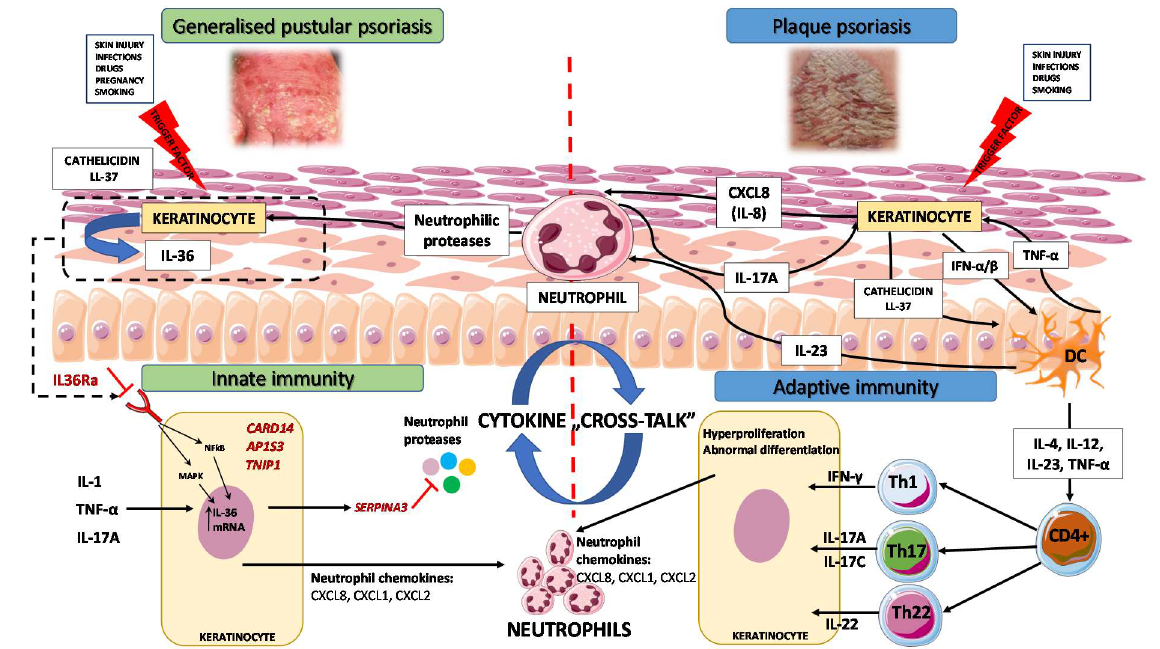
Figure 1. Pathogenesis of generalized pustular psoriasis and plaque psoriasis—a cross-talk between innate and adaptive immunity (modified from [63]). In GPP, skin injury causes dead keratinocytes to release cathelicidin LL-37, a protein that stimulates surrounding keratinocytes to release IL-36, which further enhances the production of different chemokines and recruitment of neutrophils, T cells, dendritic cells, and monocytes. IL-36 expression is induced by other pro-inflammatory cytokines, such as IL-1, TNF- α , and IL-17A. Additionally, neutrophil proteases process and activate IL-36 family cytokines that escalate the inflammatory process. The serine protease inhibitors SERPINA1 and SERPINA3 can inhibit neutrophil proteases, which have been shown to process full-length secreted IL-36 cytokines to their more active forms, thereby increasing their pro-inflammatory activity. The mutation of the IL36RN gene can lead to IL36Ra deficiency, aggravating the inflammatory response and triggering GPP. Other genes ( CARD14 , AP1S3 , TNIP1 ) are also known to predispose to GPP. In plaque psoriasis, various triggers can cause activation of keratinocytes and the release of self-nucleic acids and antimicrobial peptides (e.g., cathelicidin LL-37), which, along with type I interferons (e.g., IFN- α and IFN- β ), activate plasmacytoid and myeloid dendritic cells. Activated dendritic cells promote differentiation of naïve CD4+ cells into Th1, Th17, and Th22 cells. Cytokines produced by these T cells, such as IFN γ , IL-17, and IL-22, act on keratinocytes and cause